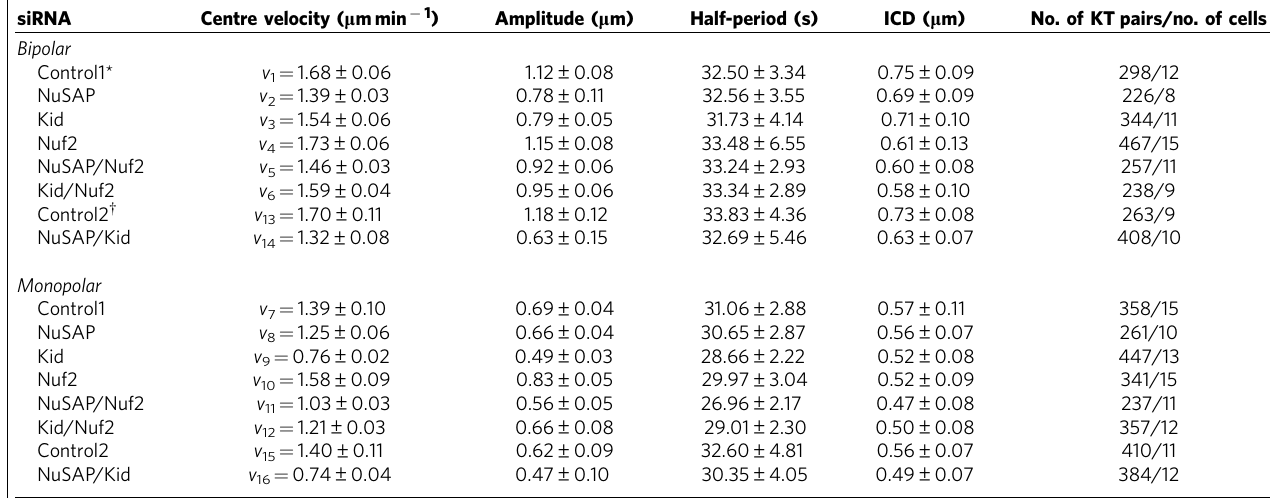
Table 1 | Summary of the parameters defining centromere oscillation in bipolar and monopolar control, NuSAP, Kid, Nuf2, Nuf2/NuSAP and Nuf2/Kid siRNA cells. siRNA Centre velocity ( l mmin (cid:2) 1 )